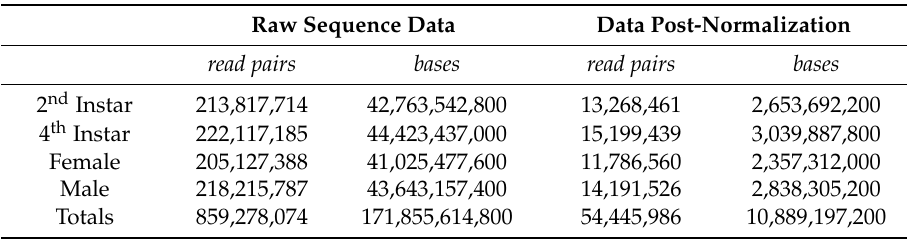
Table 1. Sequencing data volumes achieved, pre- and post-normalization. A paired-end sequencing strategy was used, with a targeted read length of 100 bp. Raw Sequence